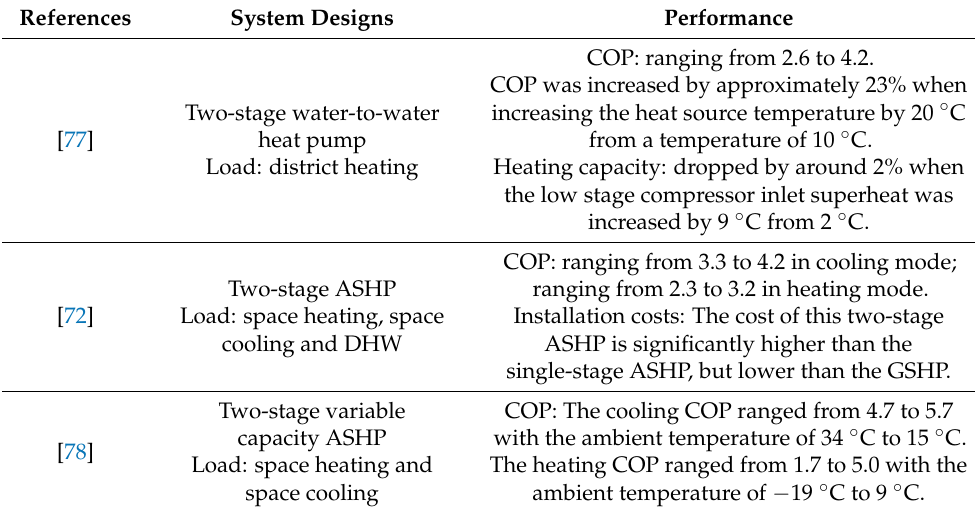
Table 6. Summary of studies of two-stage heat pump